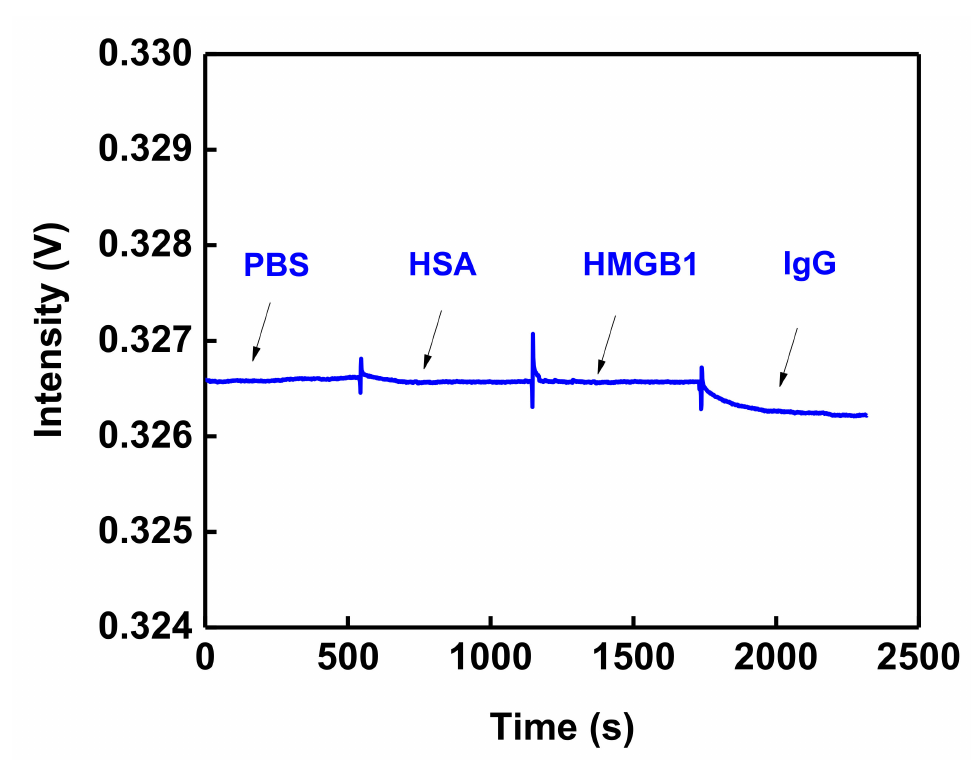
Figure 7. Nonspecific adsorption and specificity tests. The sensorgram of IgG antibody-functionalized GO-OW sensor in response to HSA (1.0 × 10 − 6 g/mL), HMGB1 (1.0 × 10 − 6 g/mL), and IgG (1.0 × 10 − 10 g/mL)